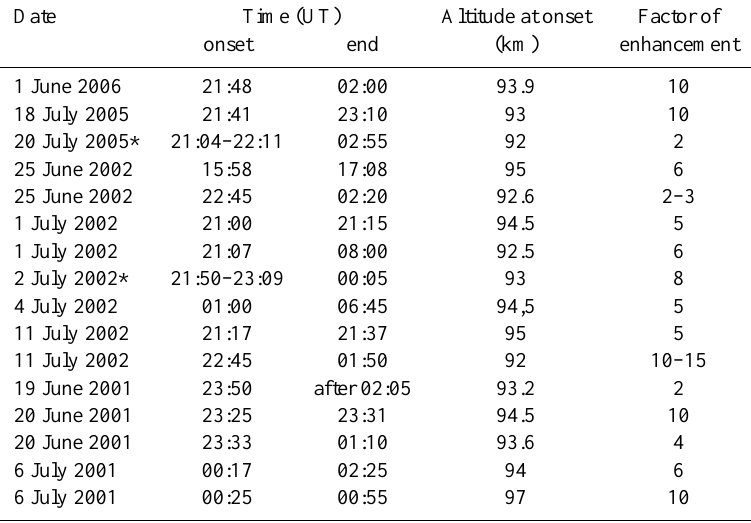
Table 1a. Observations of sudden Na enhancements above ALOMAR during June and